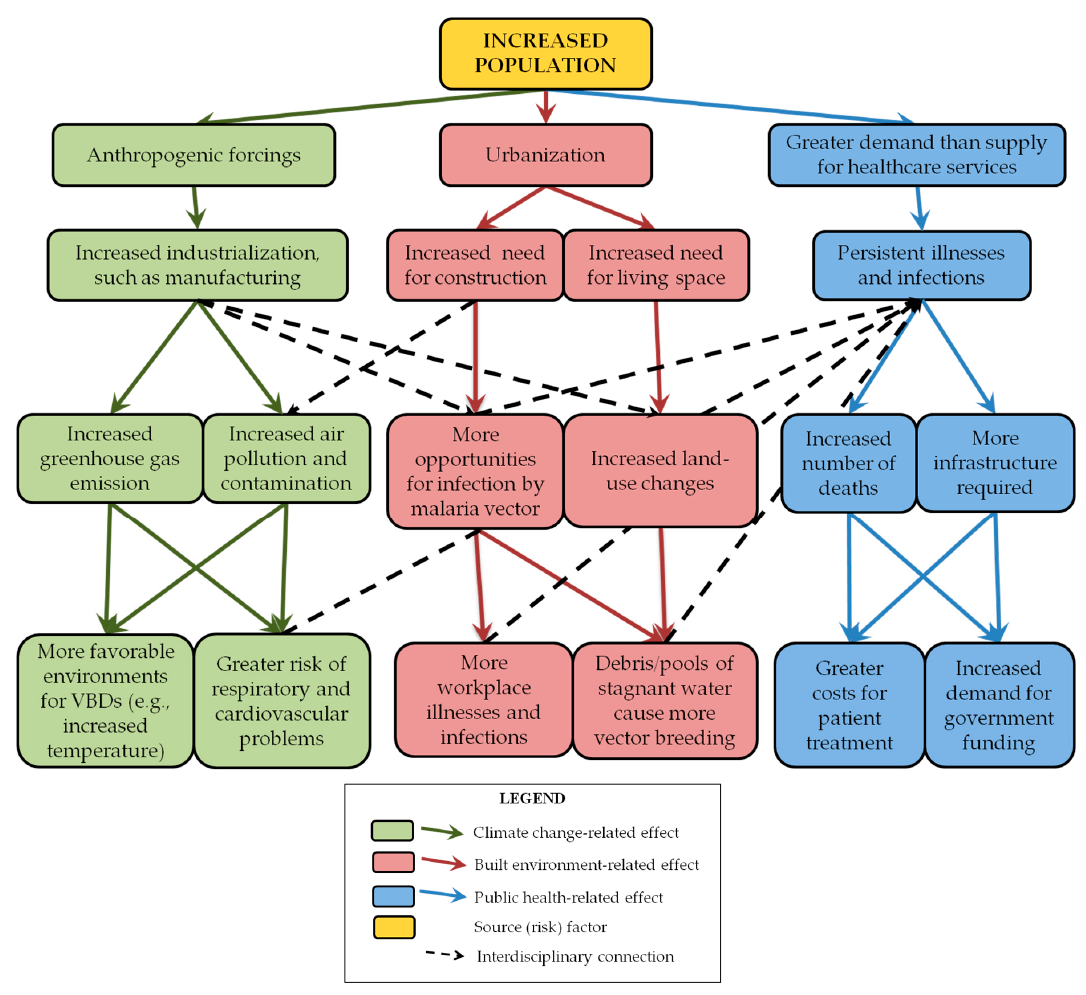
Figure 6. Source factor propagation scenario.